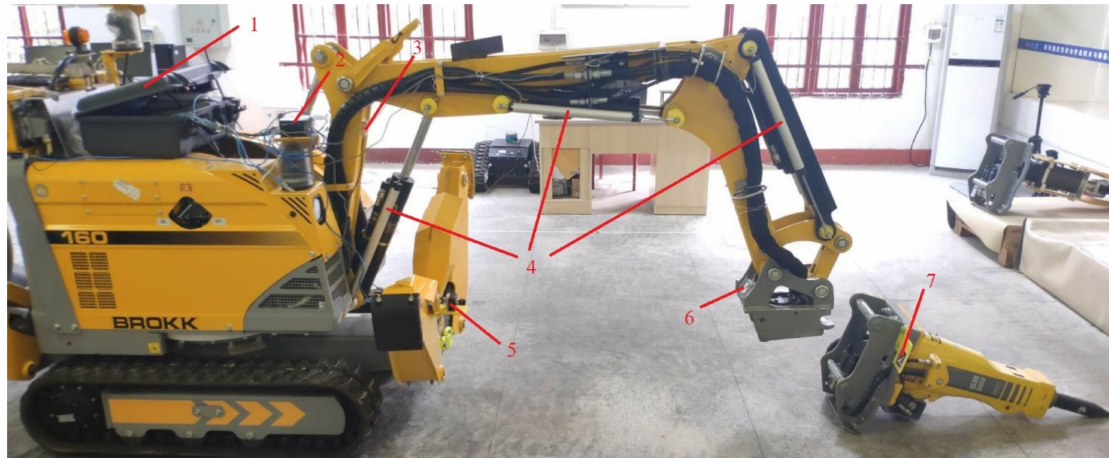
Figure 9. Attachment changing experimental conditions. (1) Nividia Jestson TX2 and sensors serial communication module, (2) wireless router, (3) inclinometer, (4) displacement sensors, (5) industrial camera, (6) error compensation reference tag, (7) positioning tag of